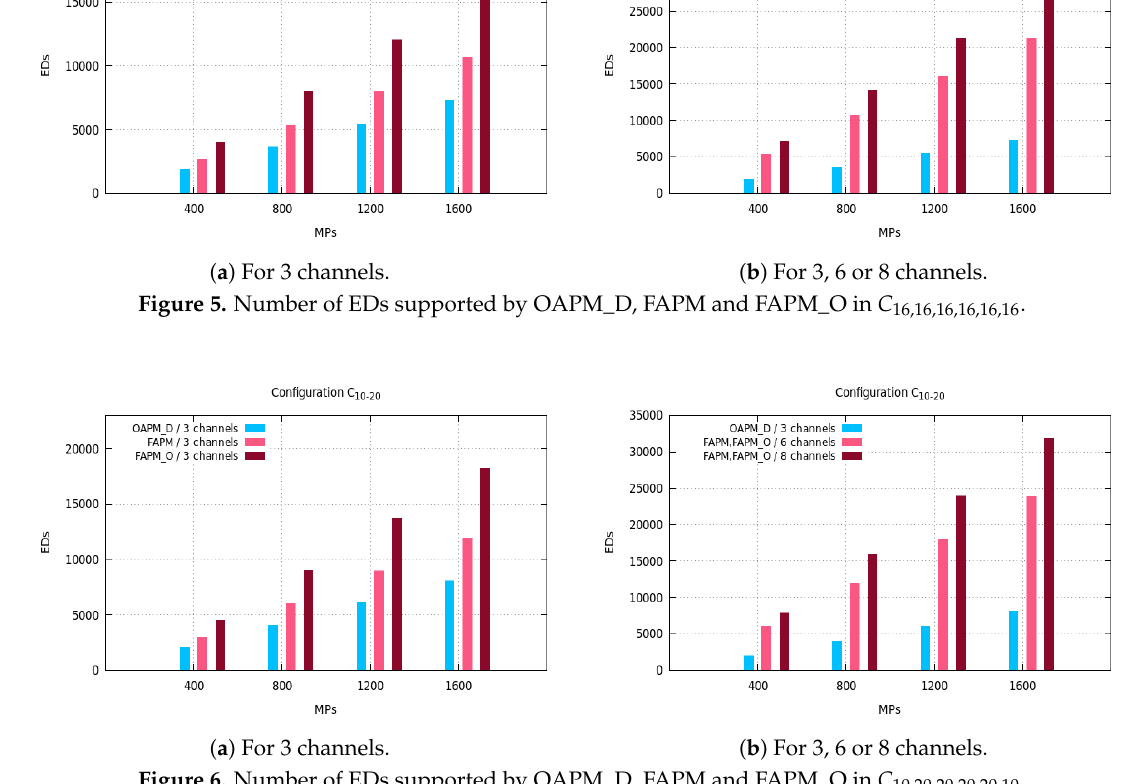
Figure 6. Number of EDs supported by OAPM_D, FAPM and FAPM_O in C 10,20,20,20,20,10 .